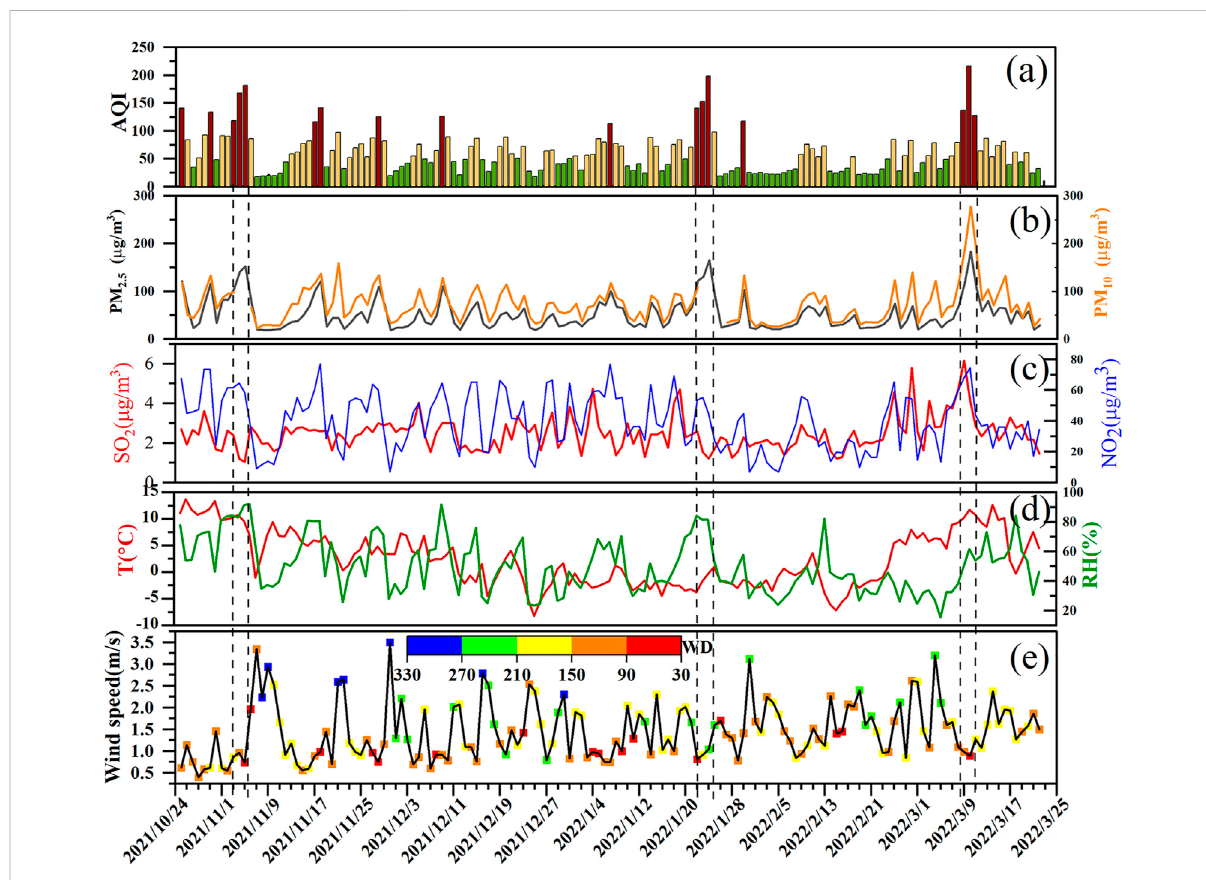
FIGURE 2 Time series of daily (A) mean air quality index (AQI); the green, yellow, and brown bars represent excellent day, good day, and polluted day, respectively; (B) time series of PM 2.5 and PM 10 mass concentration; (C) SO 2 and NO 2 mass concentration; (D) ambient relative humidity (RH) and temperature (T); and (E) wind speed and wind direction (WD); three polluted episodes are highlighted by the black dashed